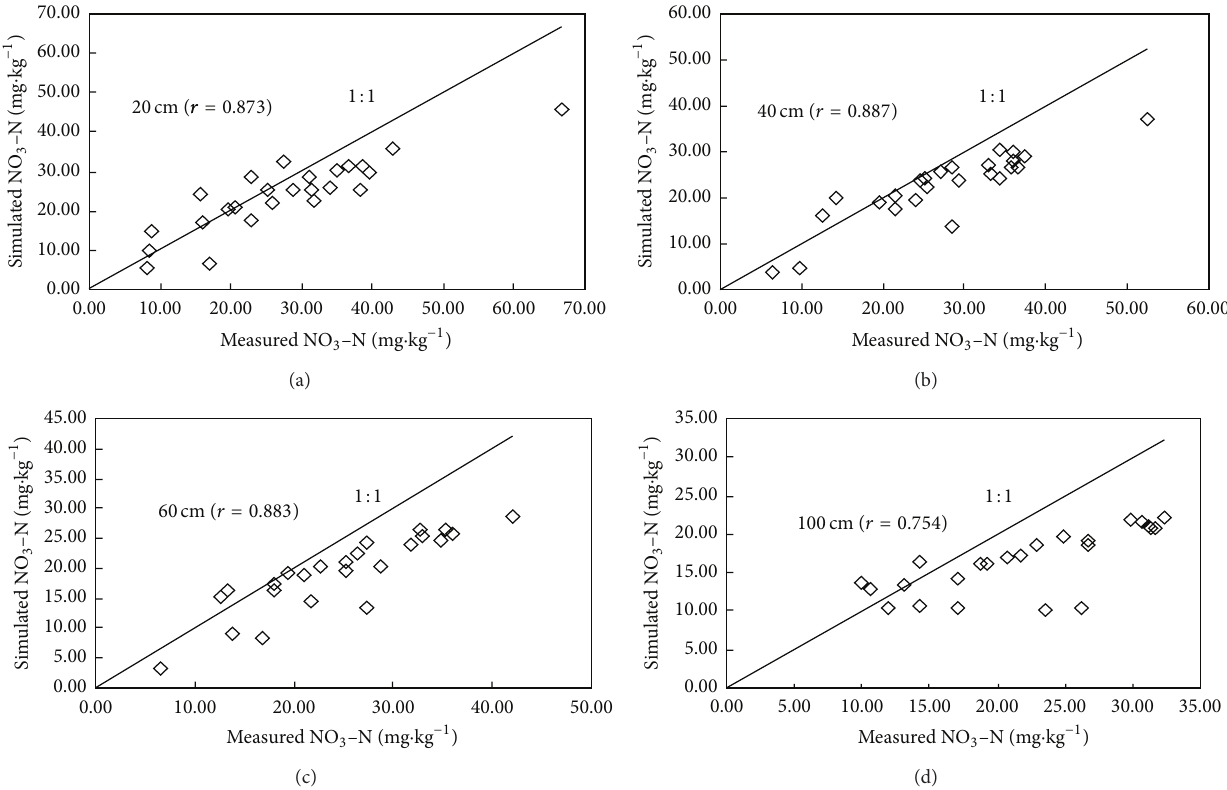
Figure 3: Comparison between simulated values and measured values of NO 3 -N with different soil layer in intensive grape orchard.